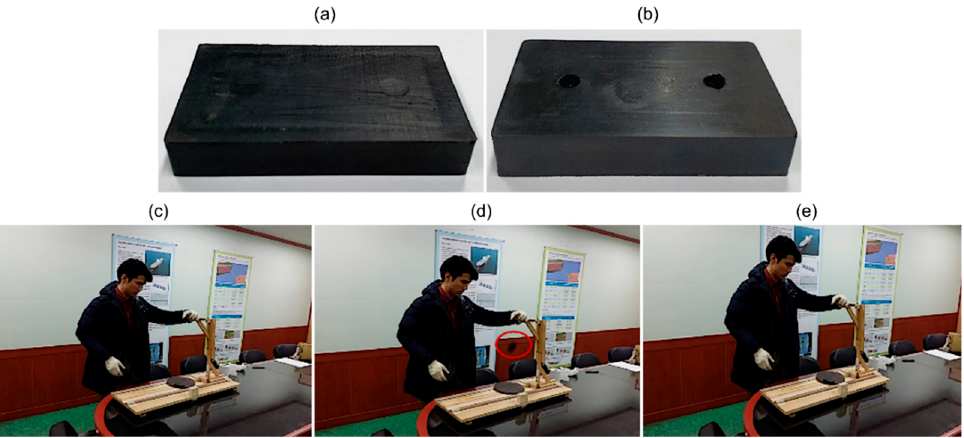
Figure 11. Top panel: Rubber-coated magnet for magnetic liquid stop device ( a ) front on the left and